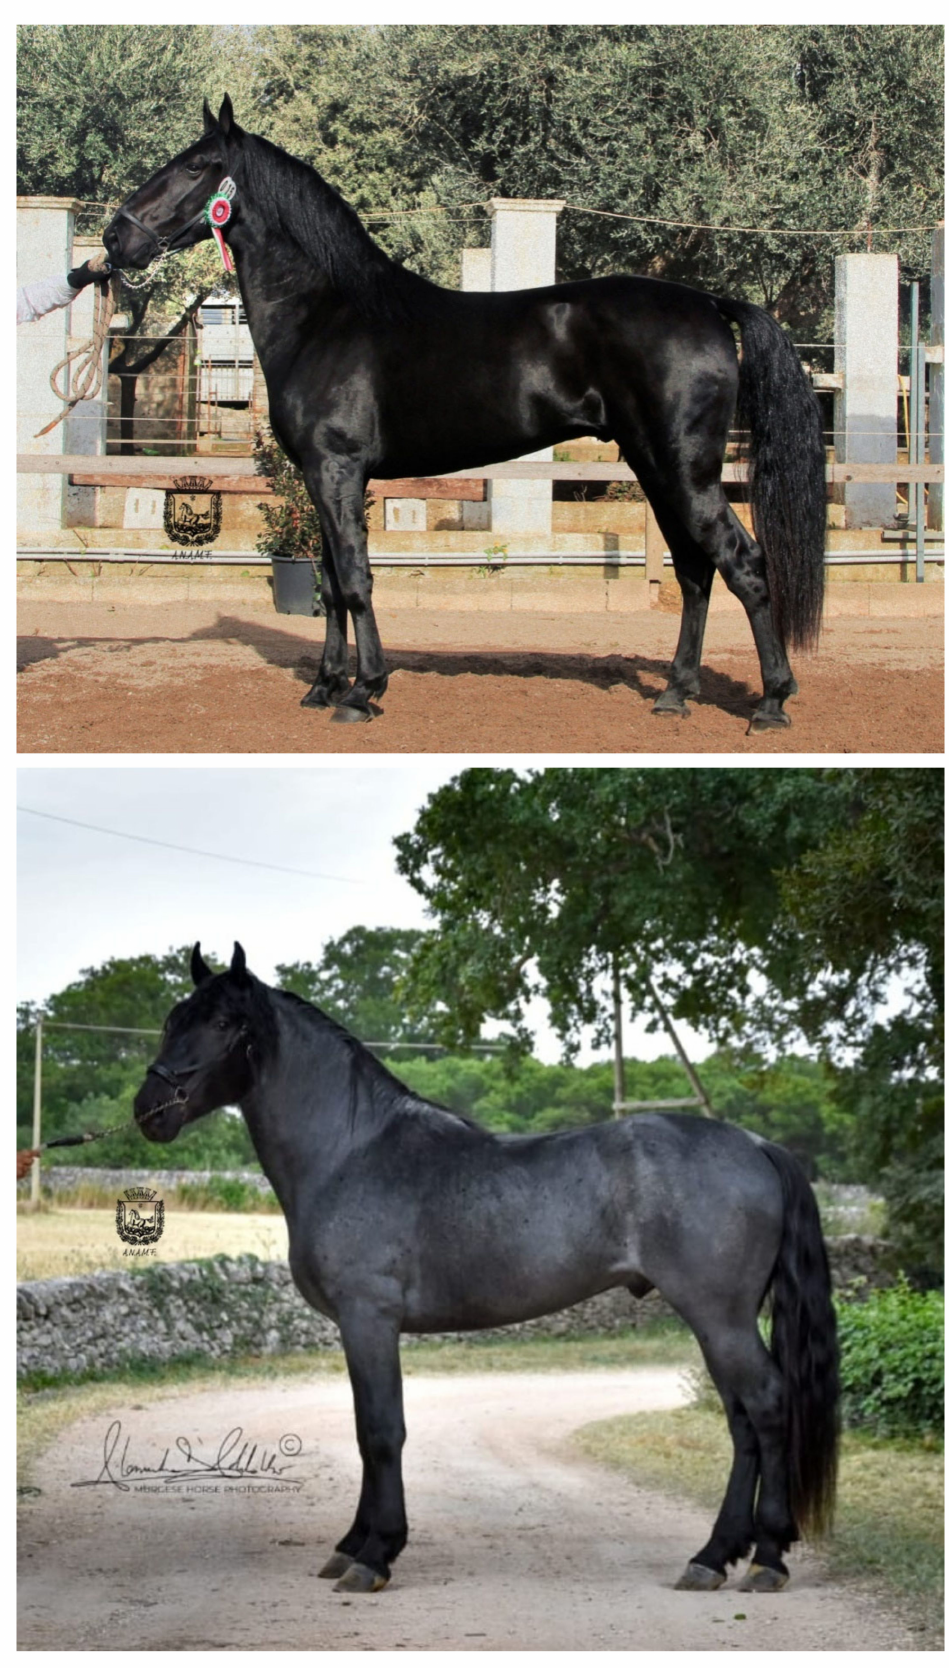
Figure 1. Pictures of a black ( top ) and roan ( bottom ) Murgese stallion (courtesy of